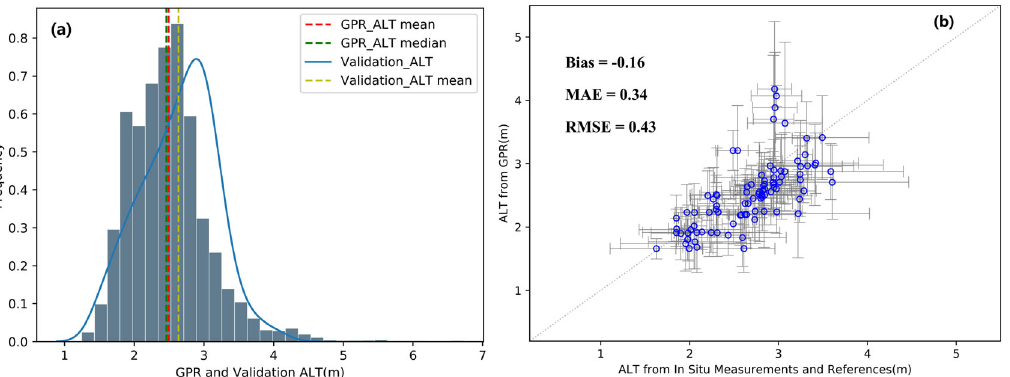
Figure 6. ( a ) Histogram depicting the proportion of active layer thickness (ALT) derived from ground-penetrating radar (GPR) and evaluation datasets, and ( b ) evaluation of ALT measured by GPR. The GPR profiles were aggregated by averaging (blue points), and the gray bar represents the range of Q1 (25%) to Q3 (75%). The validation datasets comprised in situ measurements and reference datasets from [39,40] and are shown as the aggregated mean and range of Q1 to Q3. MAE: mean absolute error, RMSE: root mean square error.